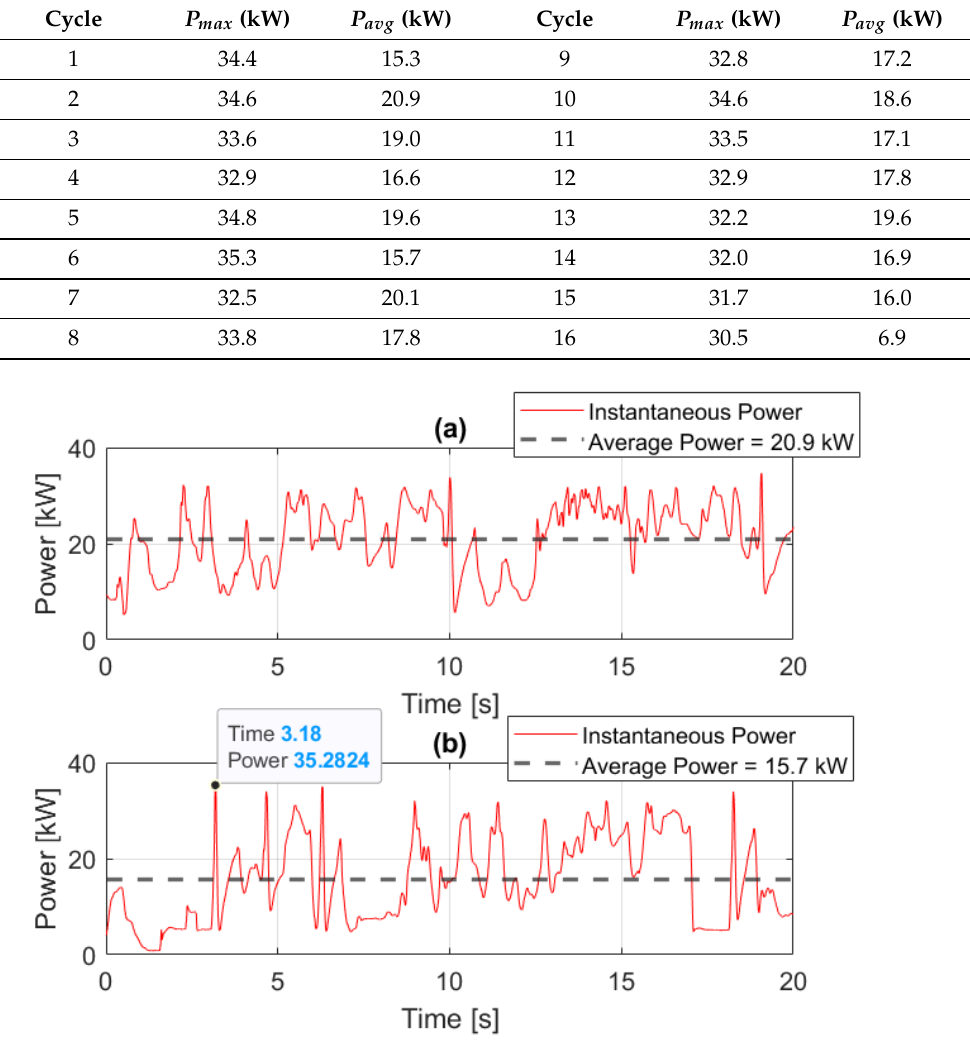
Figure 7. ( a ) Operating power during cycle 2. ( b ) Operating power during cycle